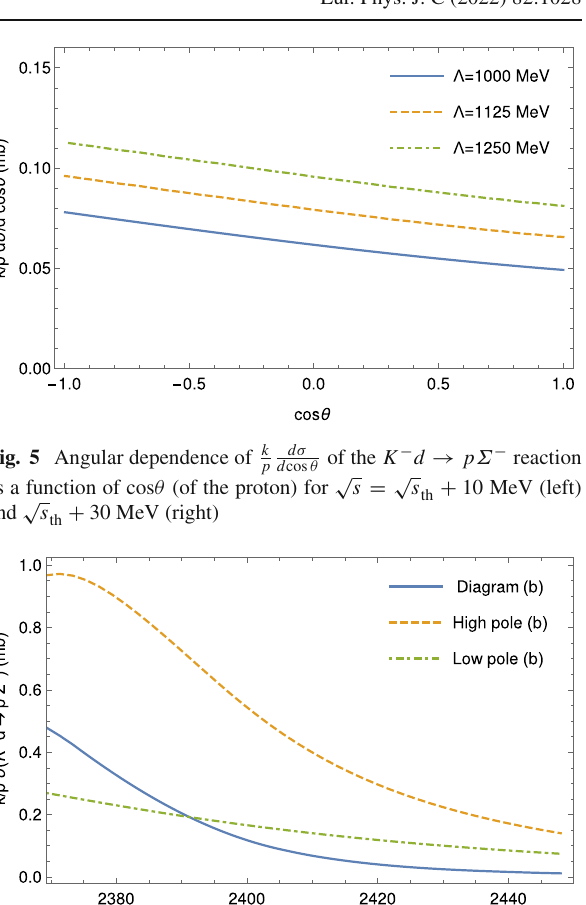
σ . p Fig. 6 Contributions of the high and low mass poles to the diagrams a and b in k p